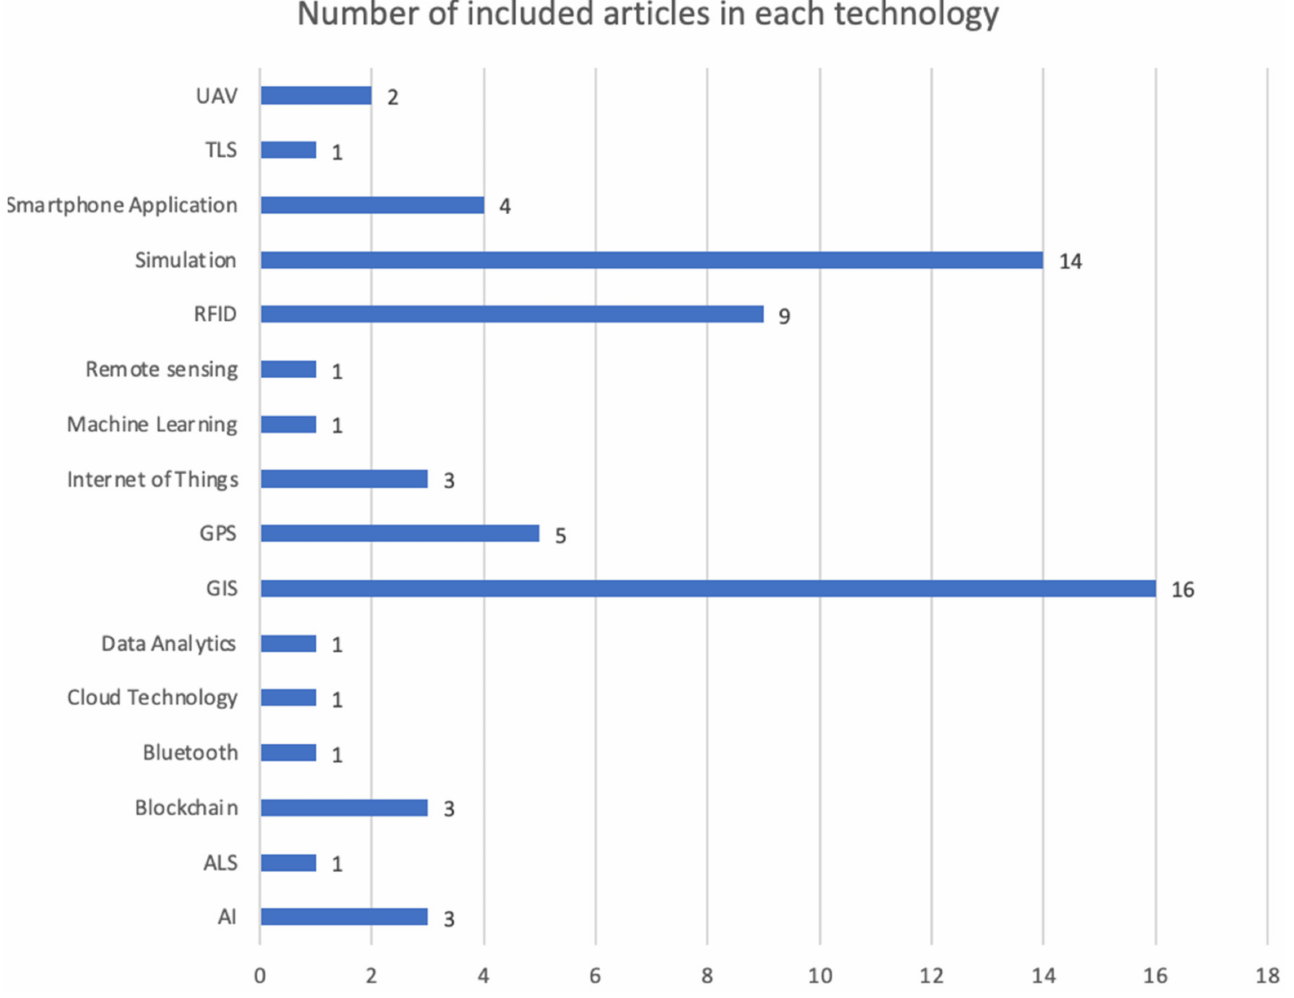
Figure 7. Number of articles mentioning each